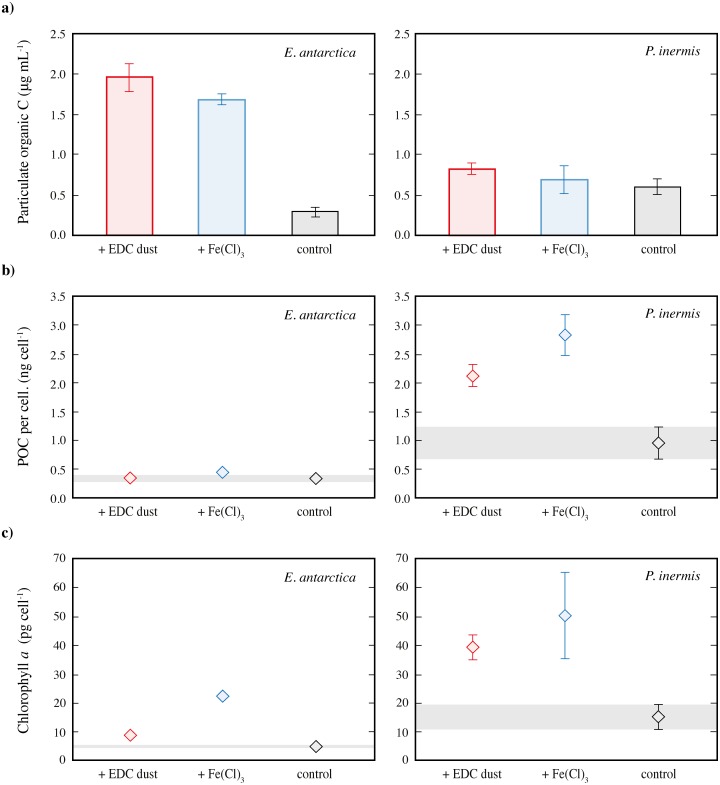
Organic carbon and Chlorophyll a produced by Eucampia antarctica and Proboscia inermis during incubations.a) final particulate organic carbon concentration in each experiment (POC; μg mL-1). b) final particulate organic carbon per diatom cell (POC; ng cell-1). c) final Chlorophyll a concentration in each incubation (μg mL-1). For each parameter, the mean of 5 replicate bottle measurements is shown, with error bars denoting ± 1SD (where bigger than the size of the symbol).